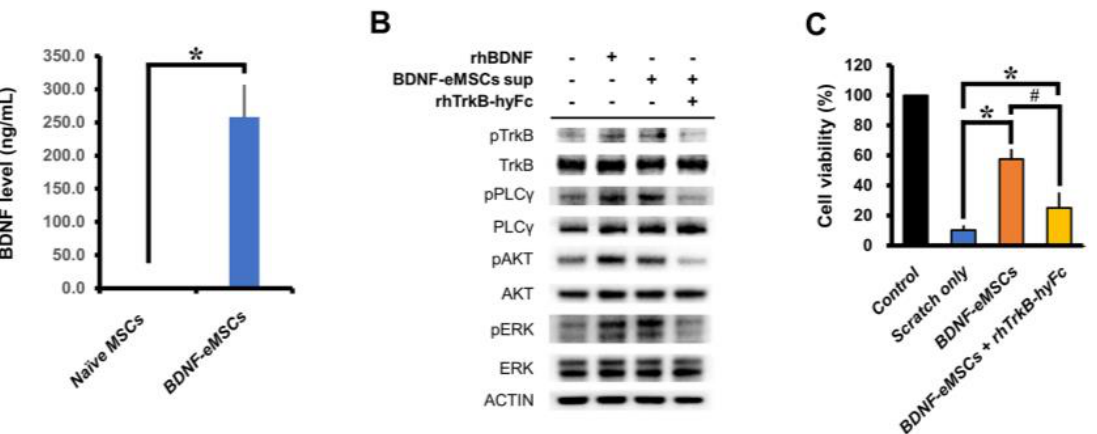
Figure 1. Characterization of BDNF-eMSCs. ( A ) BDNF secretion of naïve MSCs and BDNF-eMSCs measured by ELISA. Data are mean ± SEM; n = 3 per group. * p < 0.05 vs. naïve MSC group. ( B ) Representative immunoblot image showing activation of the BDNF – TrkB signaling pathway by treatment of supernatant of BDNF-eMSCs. ( C ) Analysis of cell viability by in vitro scratch assay after co-culture with BDNF-eMSC. Data are mean ± SEM; n = 4 per group. * p < 0.05 vs. scratch-only group; # p < 0.05 vs. BDNF-eMSC-treated group (One-way analysis of variance [ANOVA] followed by Bonferroni post hoc test: F = 39.54, p < 0.0001).